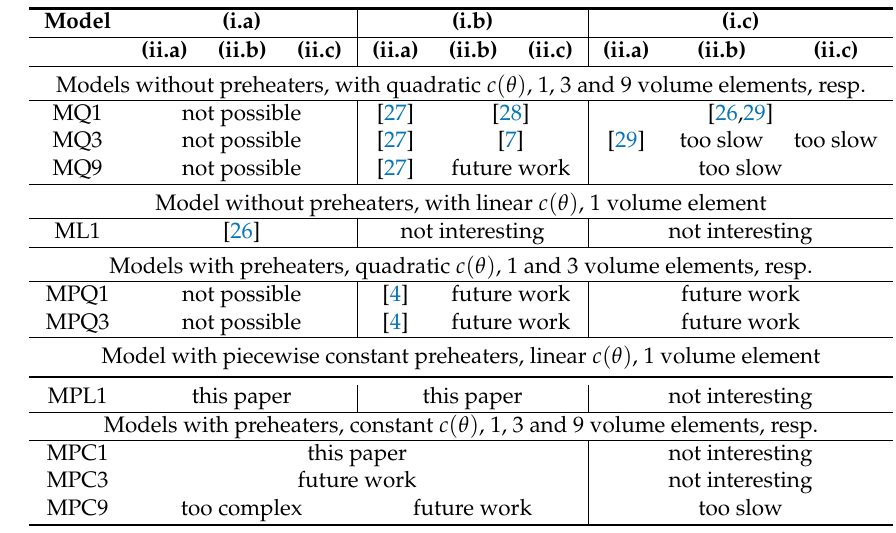
Table 1. Options for modelling and simulation of